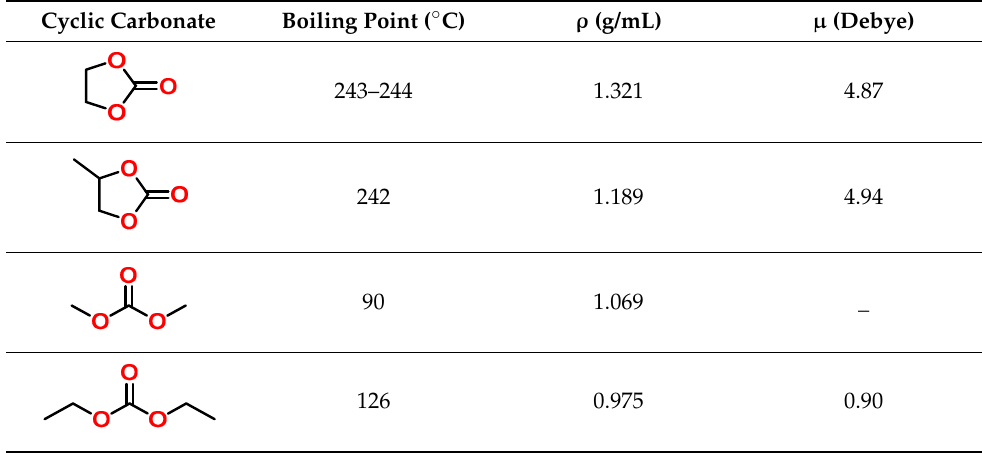
Table 2. Boiling point, density ρ and dipole moment µ of some cyclic and acyclic carbonates. Cyclic Carbonate